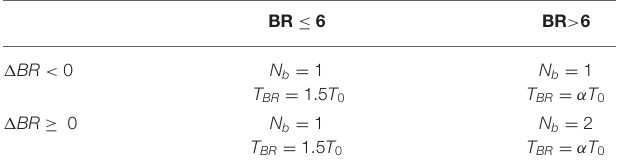
FIGURE 3 | Screen shot of the visual feedback application (A) , and the pacing application (B)